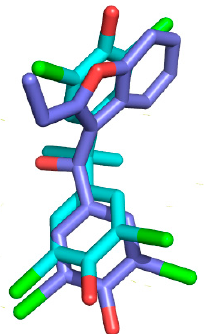
Figure 8. Close superposition of TTR AA’ binding site of the complexes of TTR with BBM and with TBBPA (PDB ID: 5HJG). Only the ligands are shown to highlight the similarities of their binding modes. The orientation of the protein binding site is similar to the one in Figure 7. BBM and TBBPA atom colors as in figure 7 except for TBBPA carbon atoms shown in light blue.